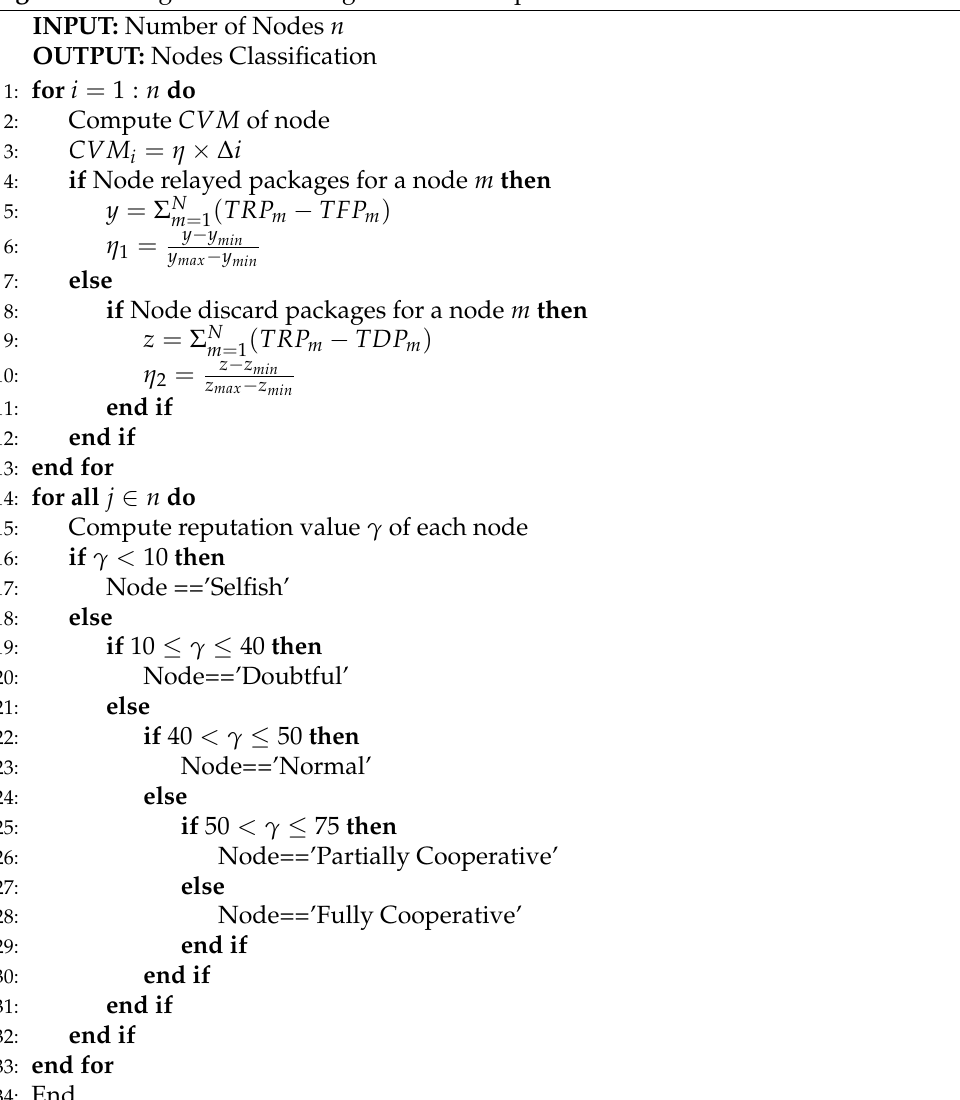
Algorithm 1 Algorithm for Categorization